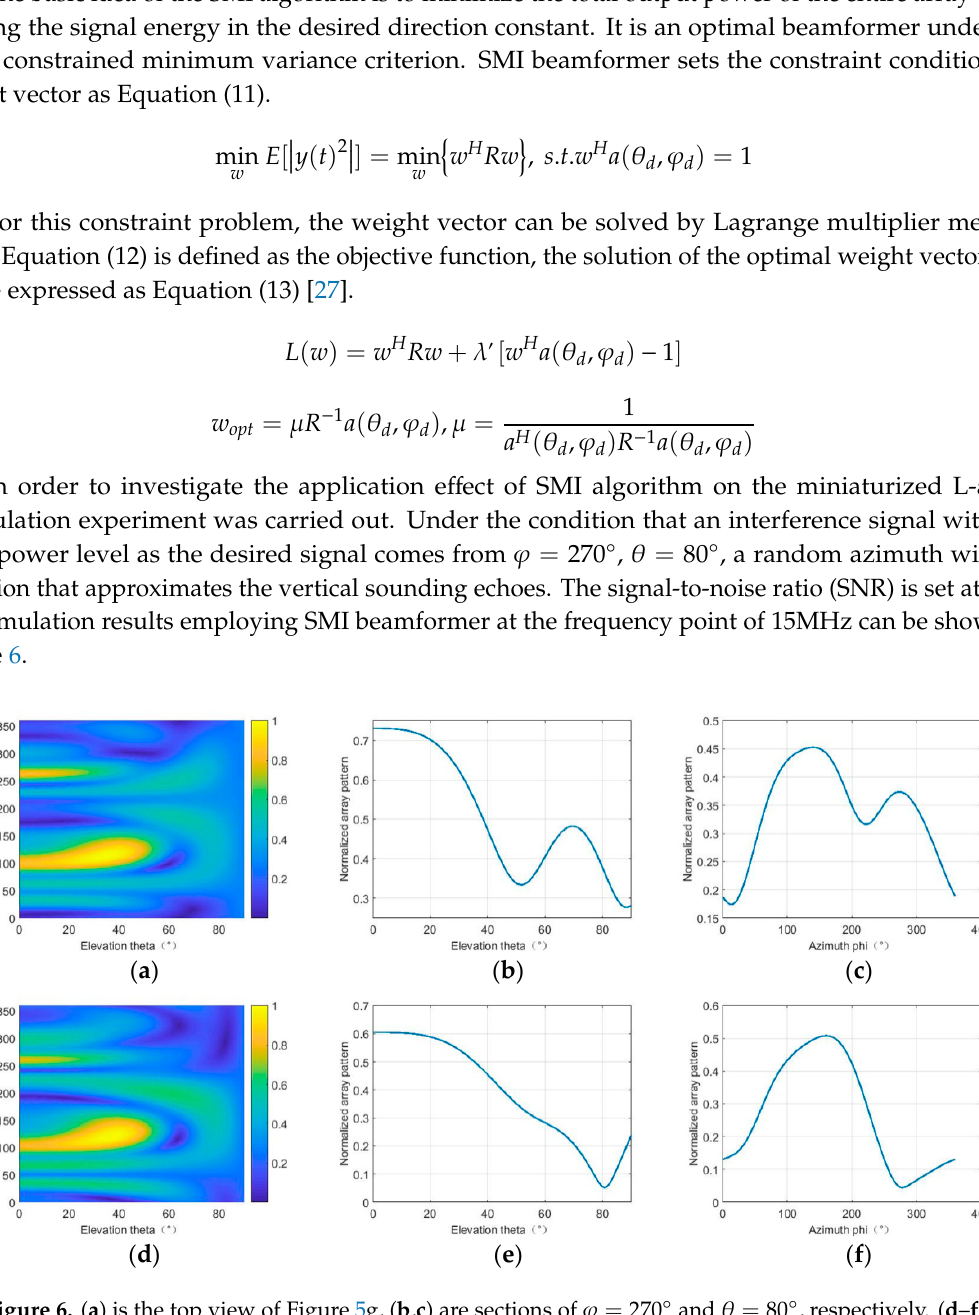
Figure 6. ( a ) is the top view of Figure 5g, ( b , c ) are sections of ϕ = 270 ◦ and θ = 80 ◦ , respectively. ( d – f ) are the corresponding results of using SMI optimal beamformer.